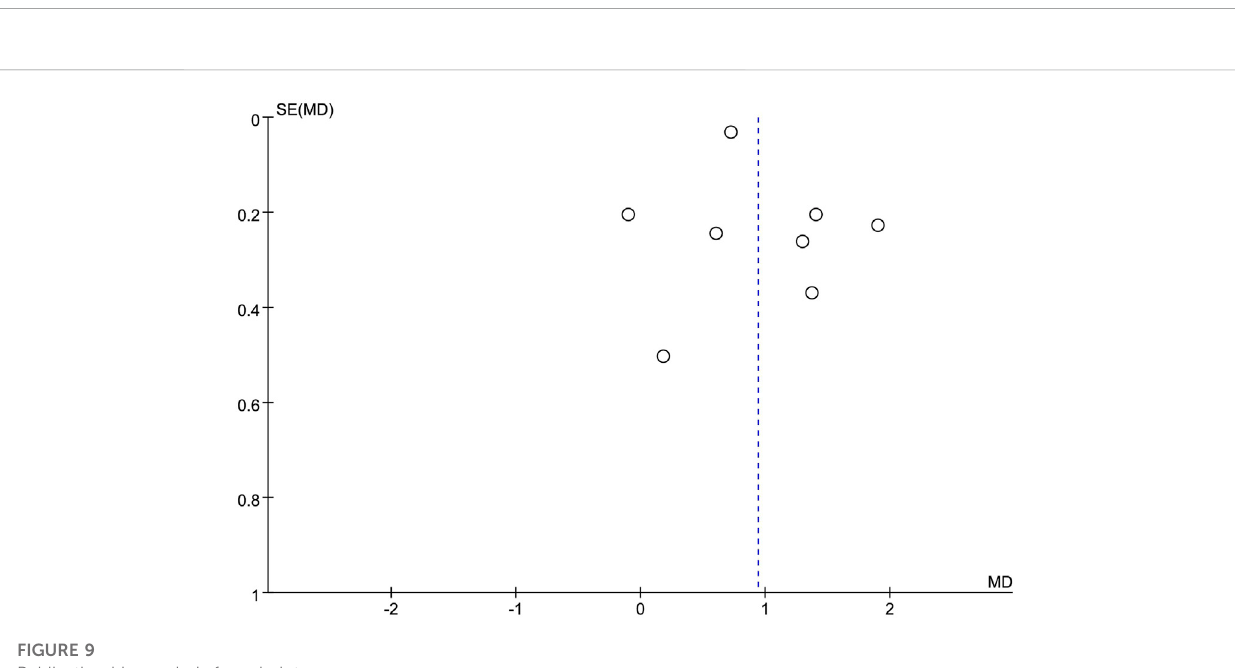
FIGURE 8 Forest plot of adverse effects in the probiotic intervention group versus that of the control group, with OR and a 95% CI analyzed analysis using a fi xed- effects model.